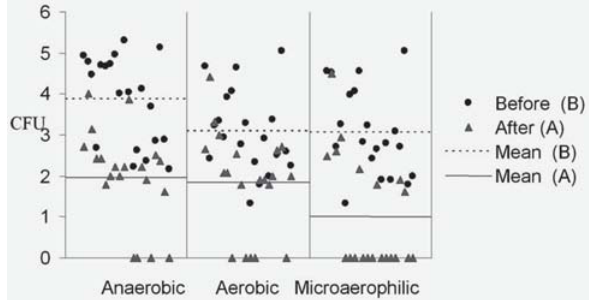
FIGURE 1- Graphic representation of microorganism count logarithms in CFUs relative to Group 1